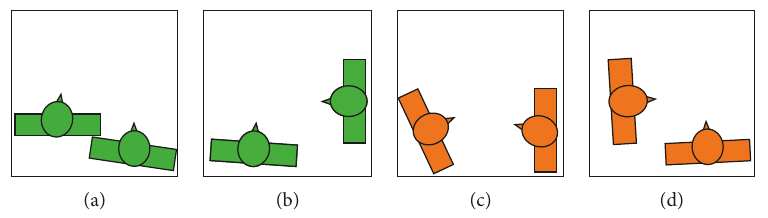
Figure 5: 2 p/m 2 , green: remaining silent, orange: speaking, door at the top.